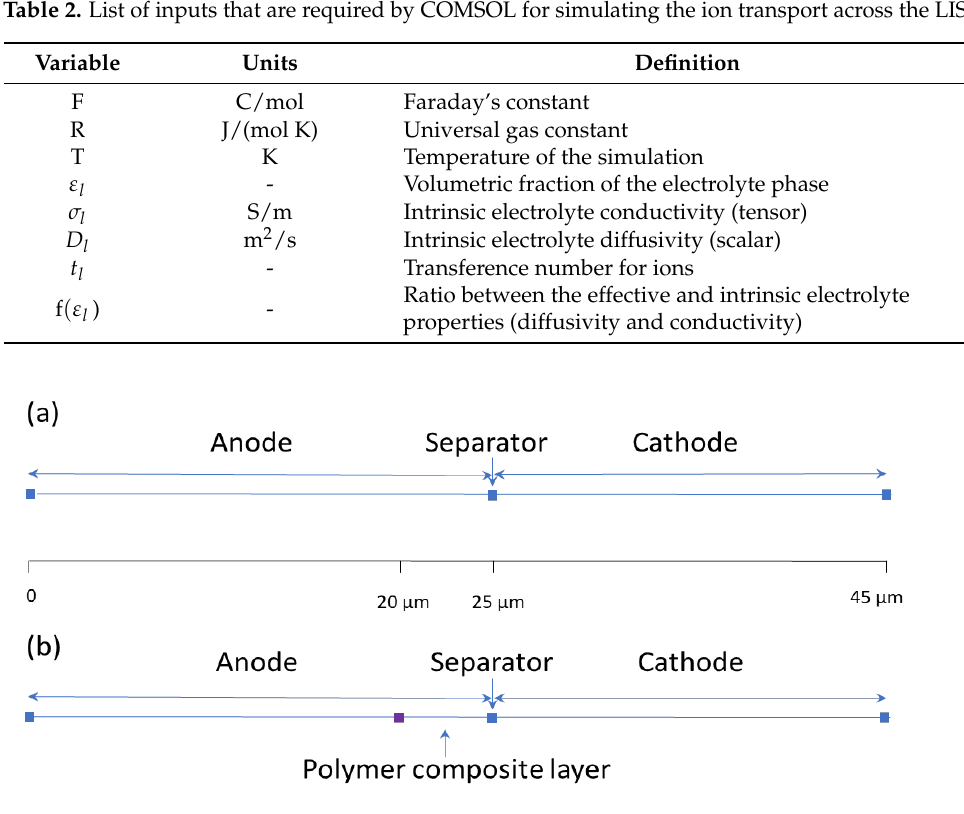
Figure 1. A schematic diagram of the 1D LISBs as they appear on COMSOL: ( a ) Without polymer composite layer; ( b ) With polymer composite layer (purple square).